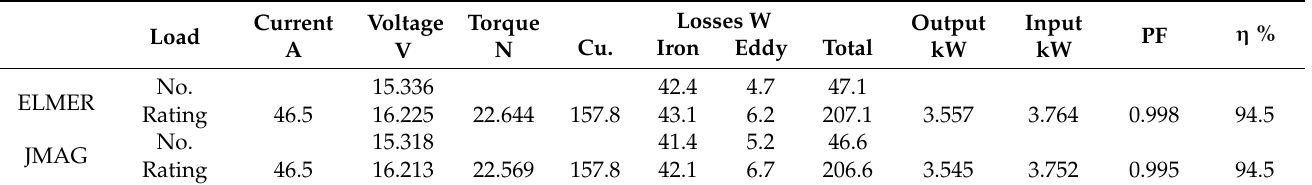
Table 2. Material list for the five-phase PMSM.